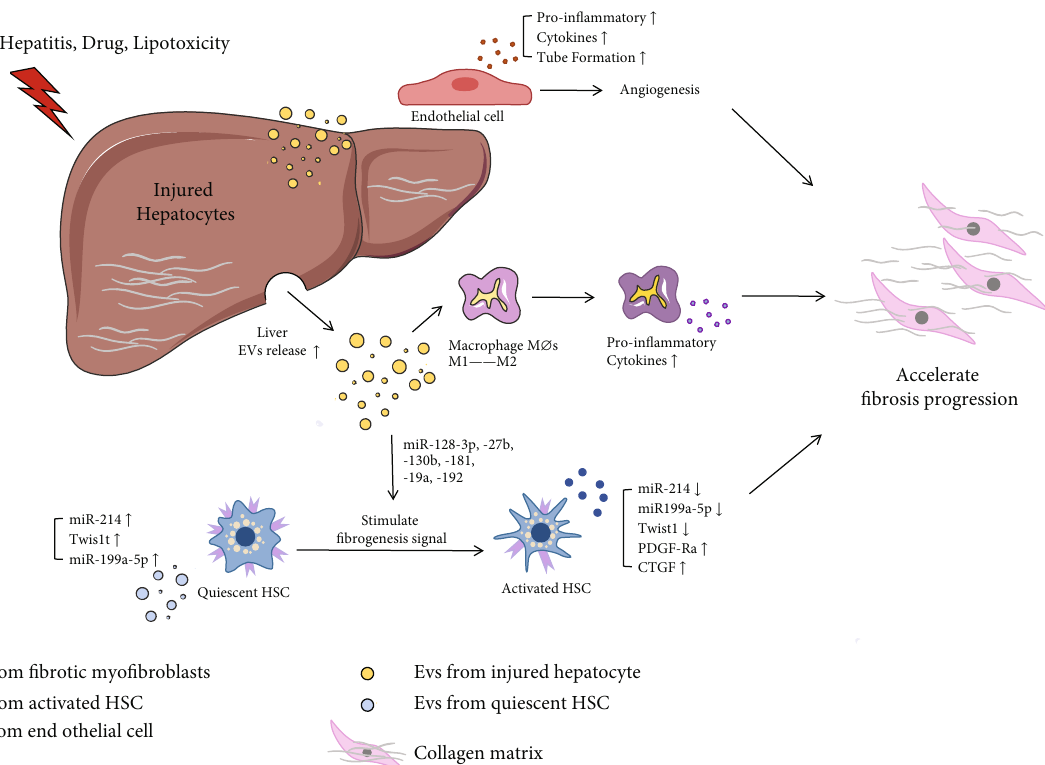
Figure 1: Functions of exosomes in the pathogenesis of liver fi brosis. Hepatocyte-derived exosomes activated by the exposure to alcohol, lipotoxic damage, and hepatitis virus. A variety of di ff erent pathways mediate chronic in fl ammation that exacerbate liver fi brosis. Immune cells secrete a large number of proin fl ammatory factors to promote the in fi ltration of in fl ammatory cells and aggravate liver in fl ammation. During liver injury, exosomes secreted by hepatocytes contain di ff erent types of RNAs, protein, and drive activation and function in hepatic stellate cells and macrophages. Meanwhile, LSEC vascularization and extracellular matrix deposition increased, resulting in fi brosis and liver dysfunction. The most signi fi cant markers of fi brosis are intrahepatic connective tissue dysplasia and massive di ff use extracellular matrix deposition. It is marked by upregulated expression of collagen, laminin, and α